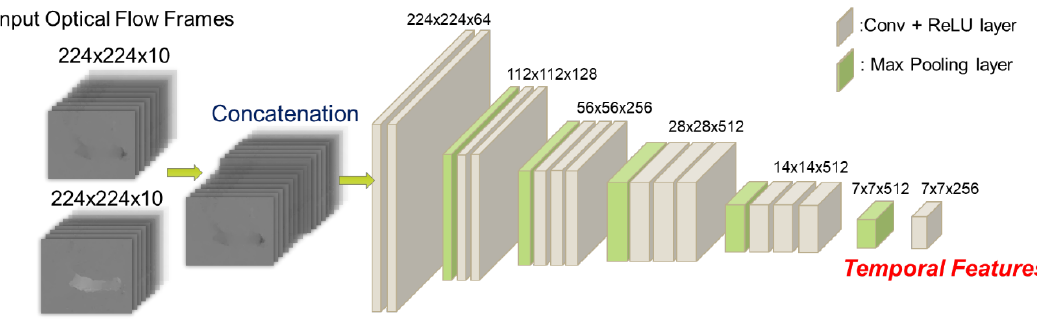
Figure 3. Configuration of temporal stream ConvNet.